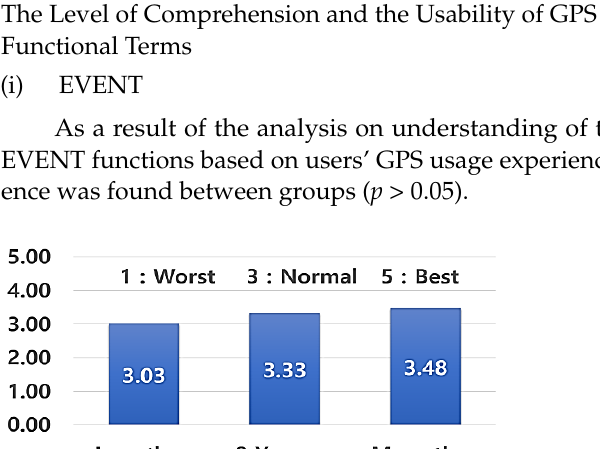
Figure A2. User preference for applying standards icons on frequently used functions by experience of using GPS plotters. Average (1: Worst to 5: Best).